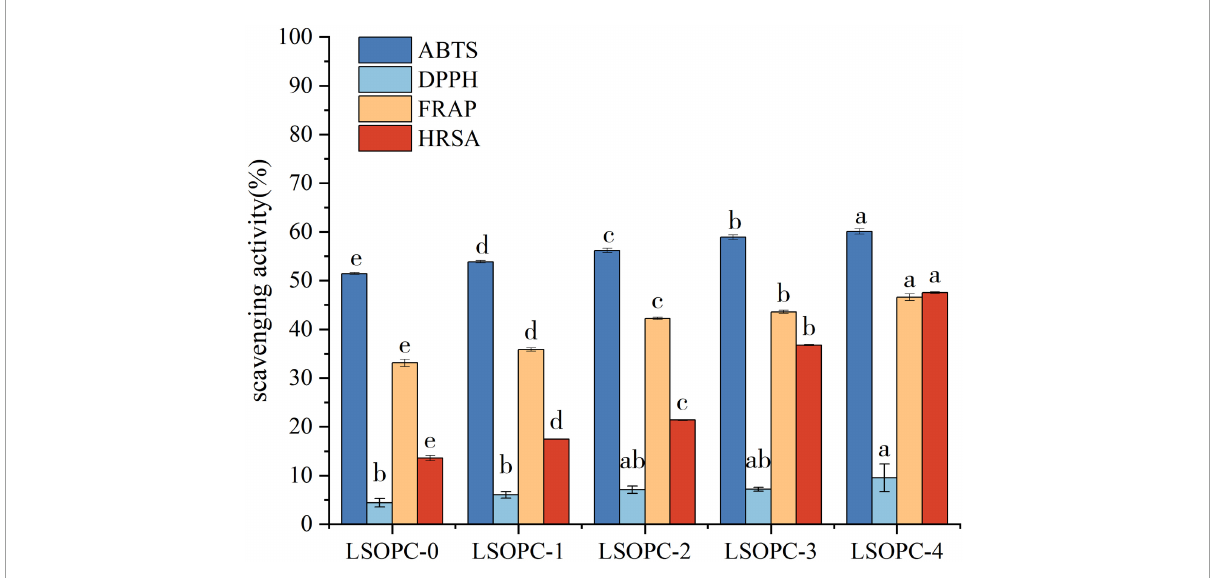
FIGURE3 Effect of LSOPC on ABTs, DPPH, HRSA, FRAP scavenging activity. Significant differences ( p < 0.05) of data values were indicated by different letters.